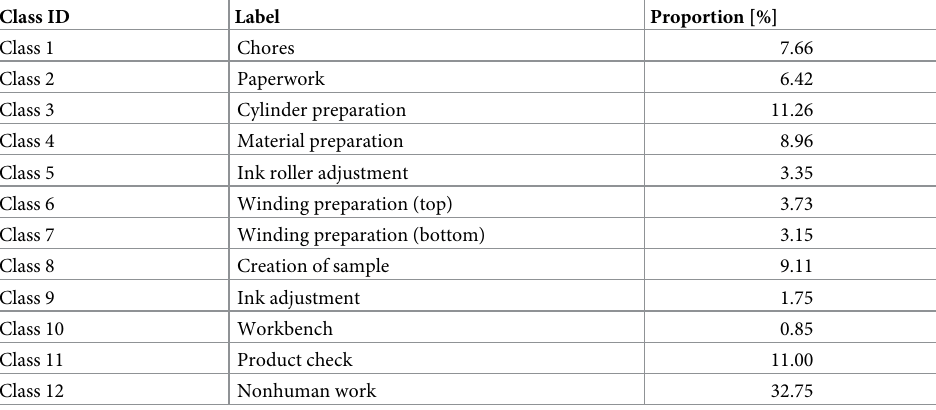
Table 4. Distribution of labels in our factory video